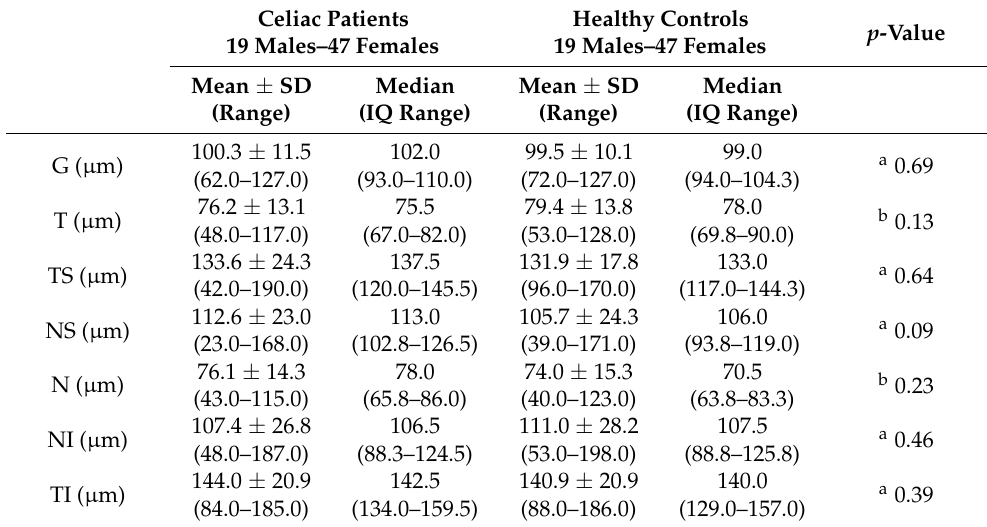
Table 5. Comparison of peripapillary RNFL thicknesses ( µ m) between celiac patients and healthy